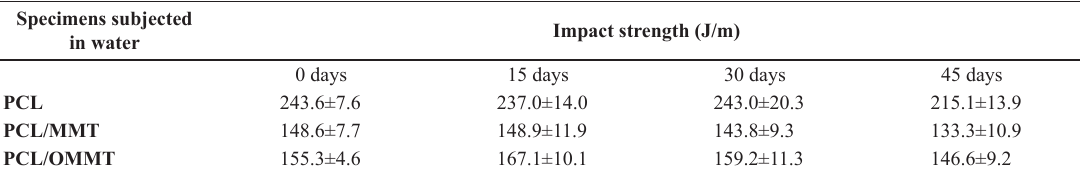
Table 3: Impact strength of PCL and PCL/MMT and PCL/OMMT compounds subjected into aqueous medium at 40 o C Specimens subjected in water